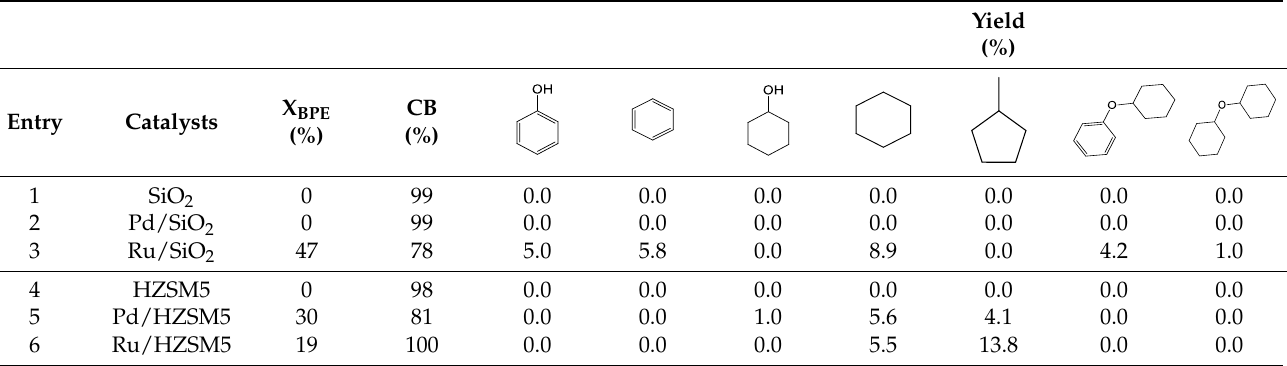
Table 5. Conversion of DPE, carbon balance, and product distribution for Ru- and Pd-based catalysts.